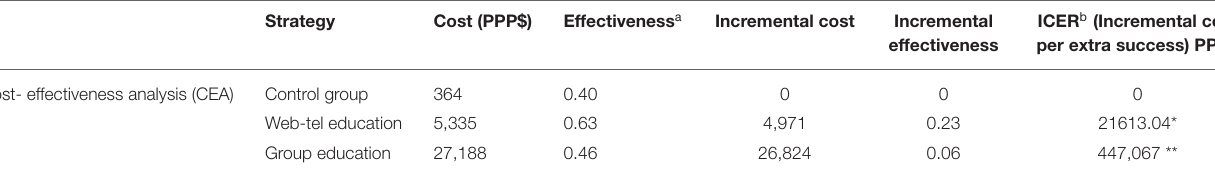
TABLE 3 | Comparing the cost-effectiveness of three methods of nutrition education in patients with